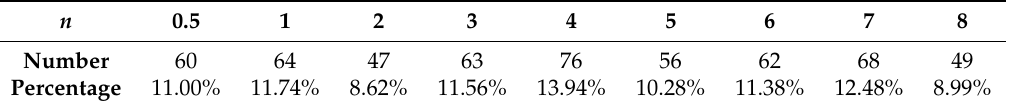
Figure 7. Statistical information of the morphological pores of different sizes and shapes in Figure 6. Table 1. Number and percentage of pores with different shapes constituting the porous microstructure in Figure